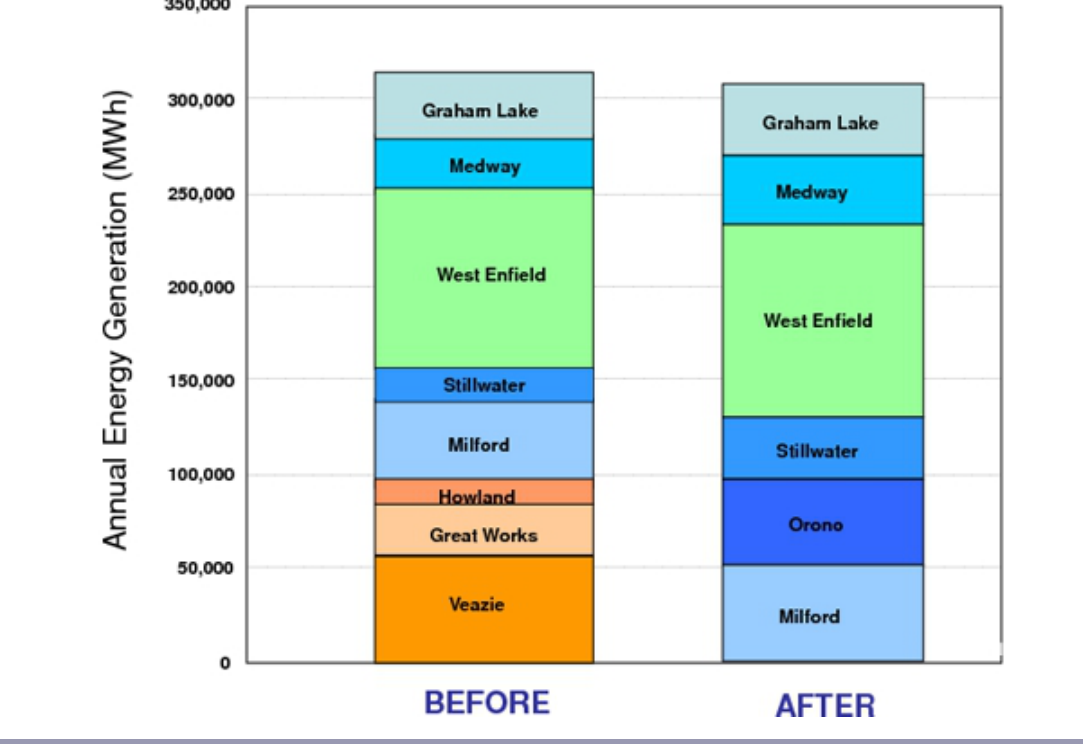
Fig. 4. Total annual energy production before and after Project completion. Dams with “warm” colors in the “before” column will be removed and are not repeated in the “after” column. Note that several dams have greater energy production after the